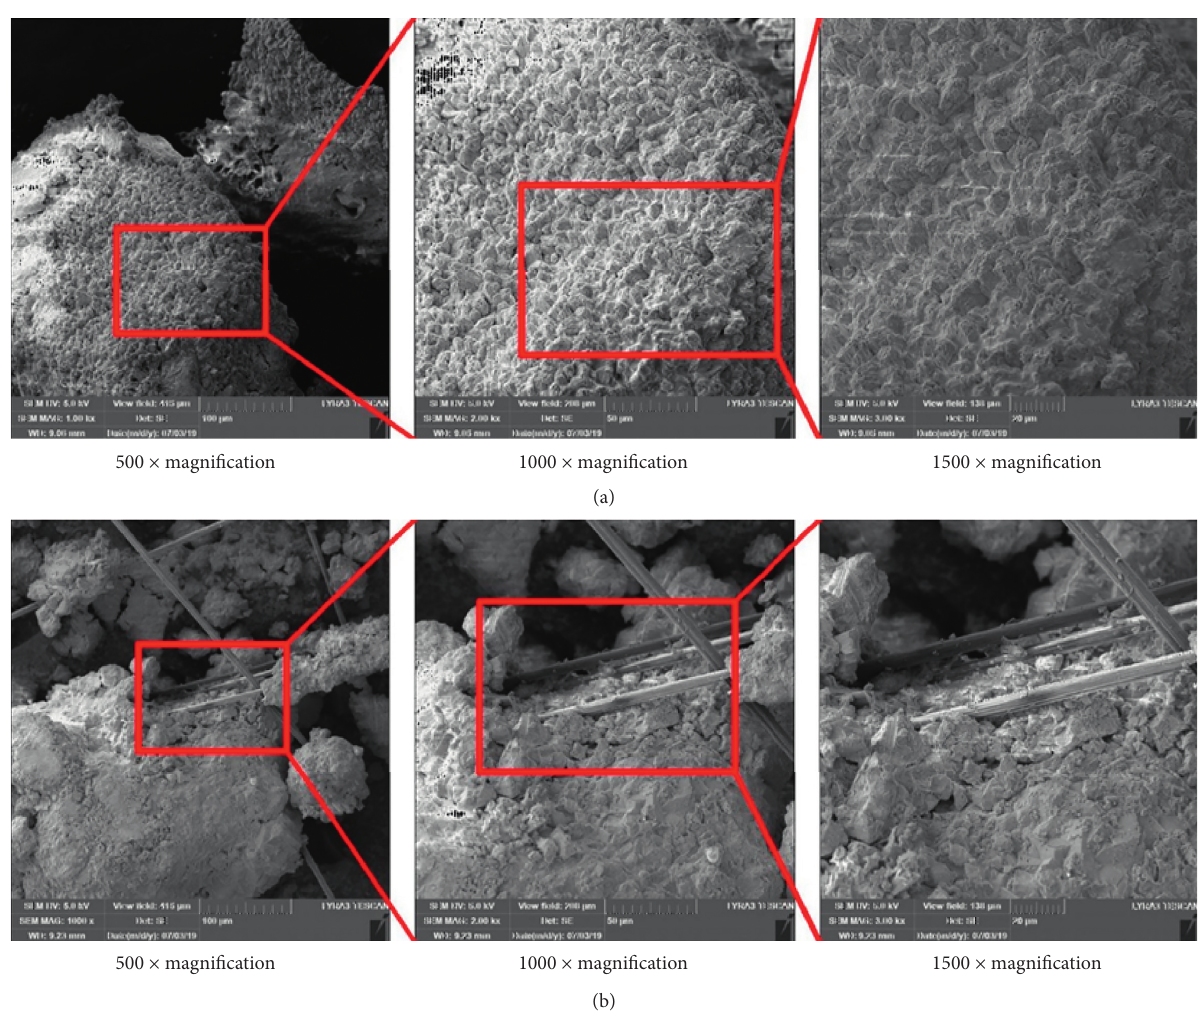
Figure 13: SEM images of calcareous sand. (a) Without fiber. (b) With fiber.